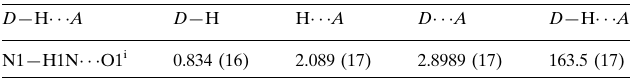
Hydrogen-bond geometry (A˚ , (cid:1)